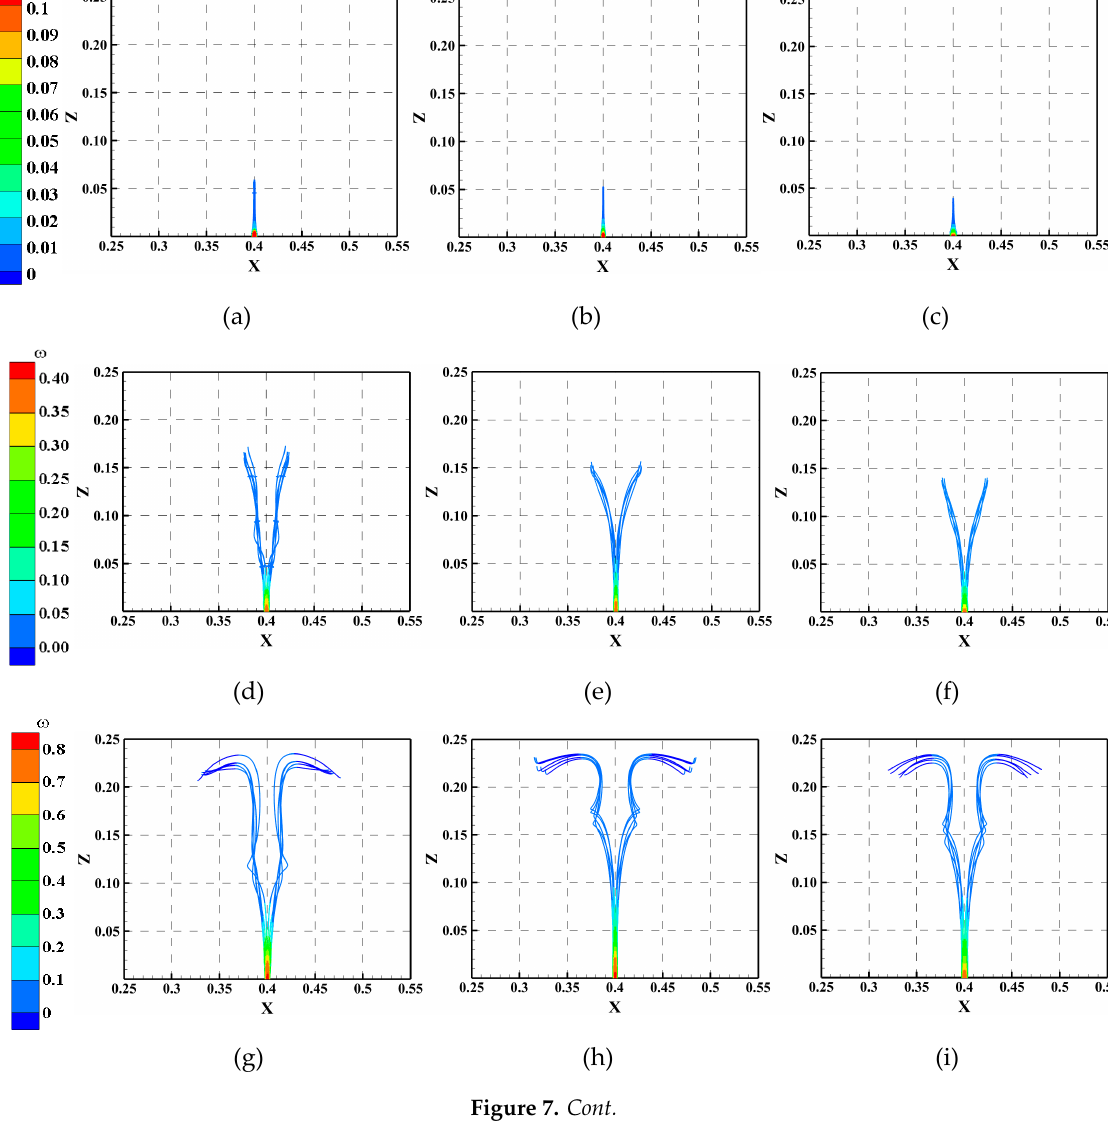
(l) Figure 7. Variations of streamtraces under different cases: ( a ) case 1, ( b ) case 5, ( c ) case 9, ( d ) case 2, ( e ) case 6, ( f ) case 10, ( g ) case 3, ( h ) case 7, ( i ) case 11, ( j ) case 4, ( k ) case 8, ( l ) case 12. As shown in Figure 7, when the velocity ratio is 2, the water is ejected from the orifice and then gradually draws closer toward the middle in the vertical direction, eventually forming a straight line without bifurcation. The shape of the jet orifice has a notable influence on the jet height and the jet height is the largest for the circular jet, followed by the square jet and then the rectangular jet. When the velocity ratio is 5, the jet beam bifurcates. The jet beams with circular and rectangular orifices bifurcate even when Z is less than 0.05 m, while the height at which the jet beam of the square orifice starts to bifurcate is relatively large, at more than 0.05 m. Further analysis reveals that the streamtrace line of the circular jet beam at the center of the orifice exhibits significant spiral deflection, while no apparent spiral deflection occurs in the jet beams with the other jet orifice shapes. When the velocity ratio is 10, there are two significant jet deflections in all the jet beams regardless of the orifice shape. The height at which the jet beam exhibits the first notable spiral deflection is the smallest for the circular jet beam, followed by the rectangular jet and then the square jet. For each of the three orifice shapes, the amplitude of the second deflection of the jet is significantly larger than that of the first deflection. After the second deflection, the streamtrace lines of the jets from the circular and rectangular orifices move vertically downward and then tend to stabilize and move downstream. After the second deflection, the jet beam with the square orifice exhibits a third deflection but with a smaller amplitude, and then tends to stabilize and move